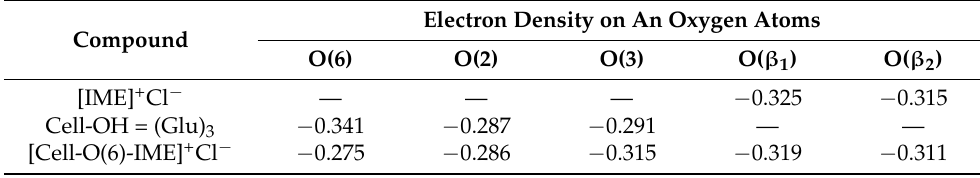
Table 6. Calculated electron-density data for analysed oxygen atoms.